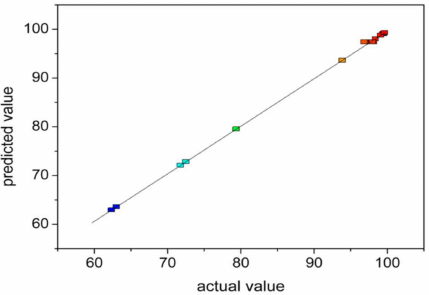
Figure 1. Corresponding relation diagram between the predicted value and actual value.